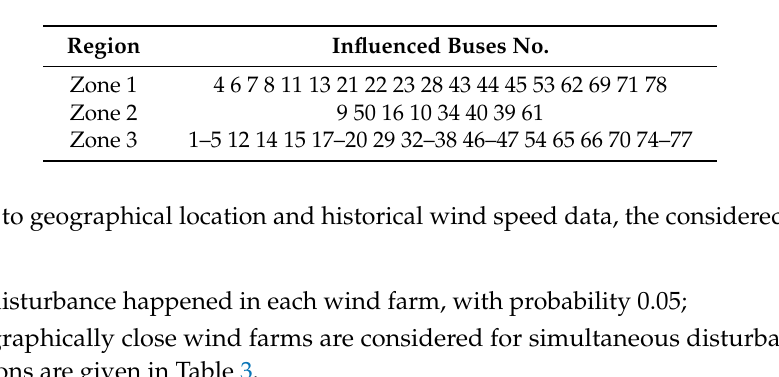
Table 2. Influence areas of each wind farm cluster.